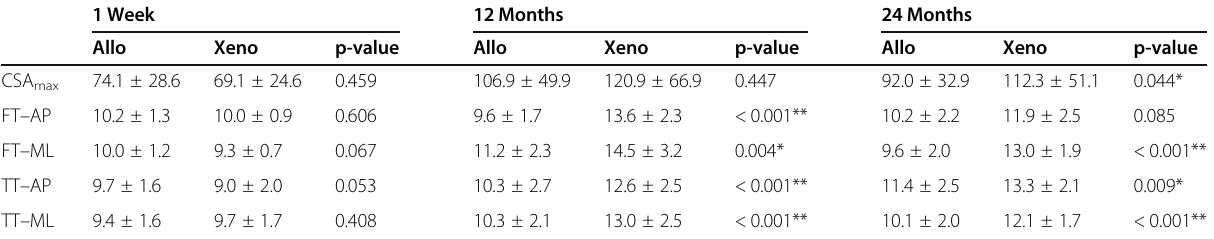
Table 5 MRI Evaluation (Cross-Sectional Area and Tunnel Dimensions) - Missing/Contaminated Graft Subjects Included (LOCF) 1 Week 12